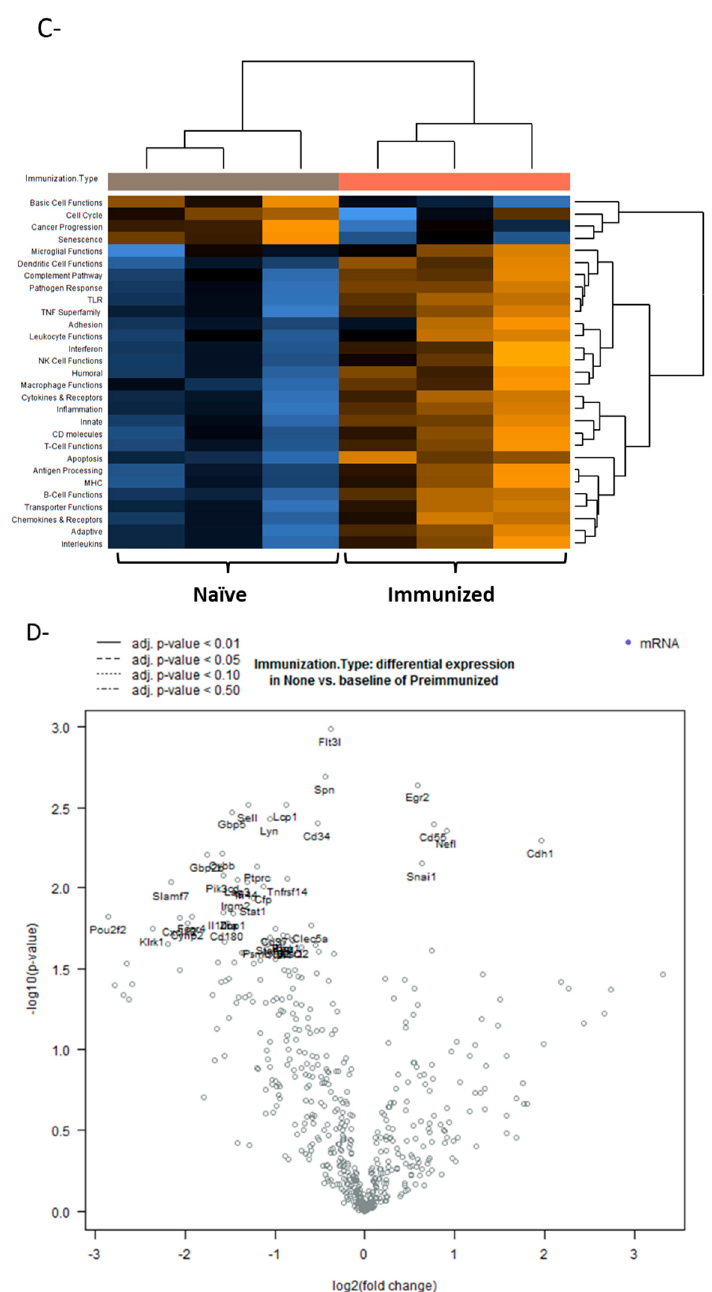
Figure 5. Cell scores in tumors treated with mVG161 comparing immunized vs. naïve mice ( A , B ). Pathway analysis shows the most significant changes in different pathways when the same tumors were analyzed ( C ). differential gene analysis of the most significantly up or down-regulated genes in the tumors of naïve and mVG161 treated mice compared to immunized and mVG161 treated mice in CT26 tumors. ( D ) Volcano plot of differentially expressed genes in tumors from naïve treated mice compared to immunized treated mice. This analysis was performed using the NanoString platform.